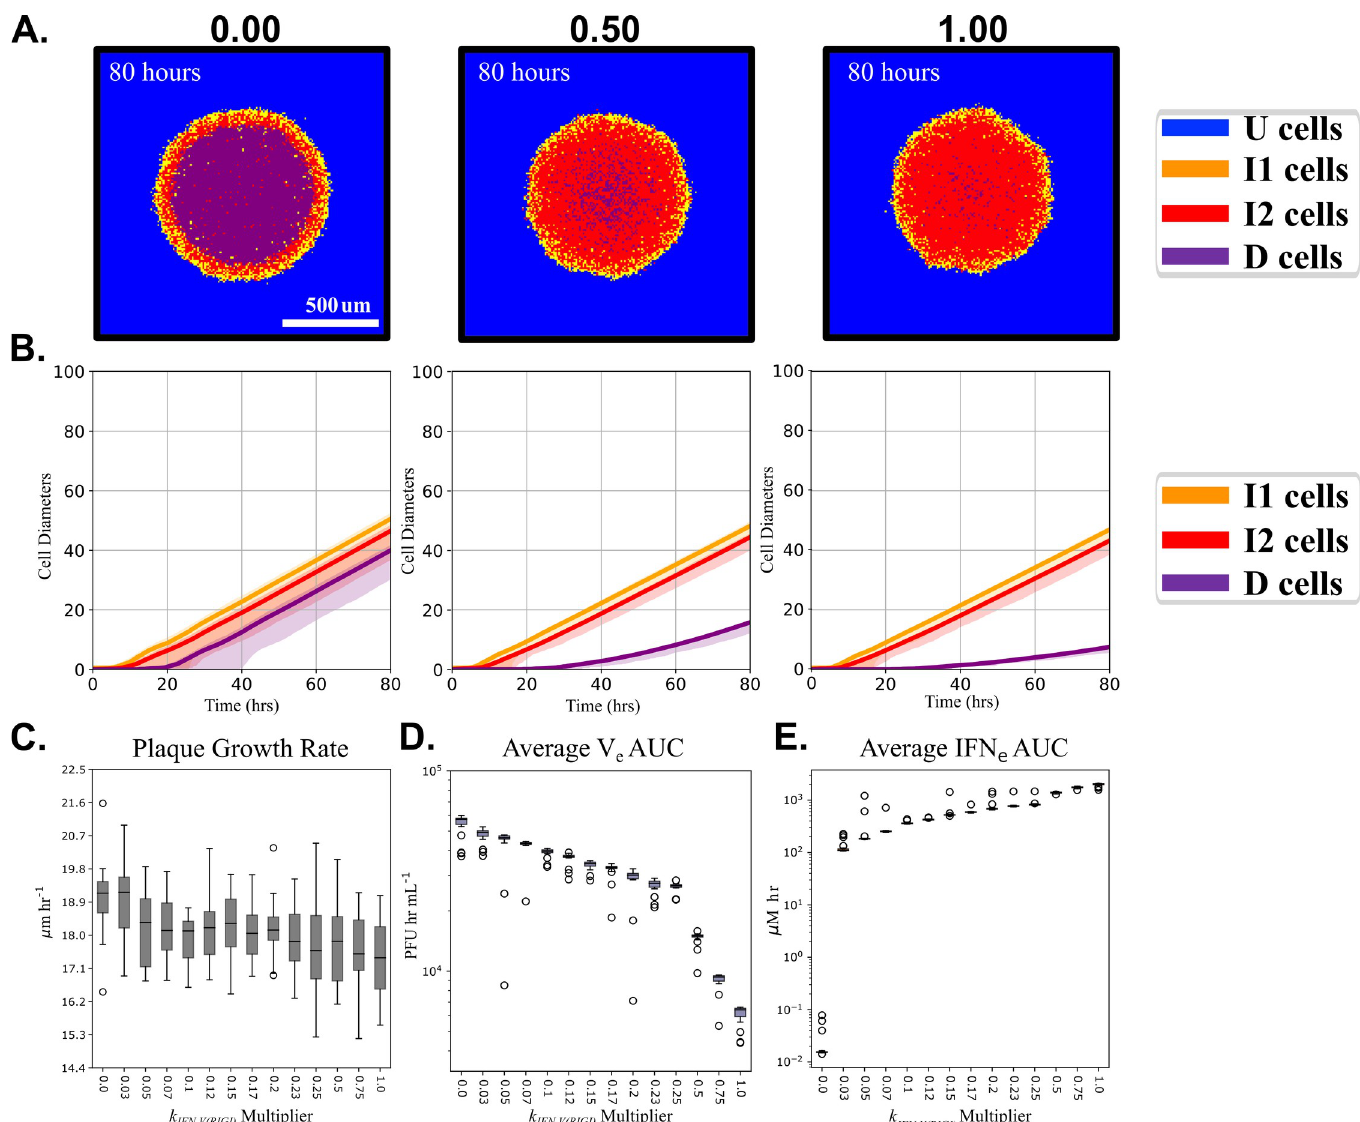
Fig 6. Increased RIG-I activity ( k IFN , V(RIGI) ) lowers plaque growth rates and viral titers, slows cell death, and increases interferon production. (A) Images of plaques at 80 hours post-infection for a representative simulation replica for three values of k (0.5E5 μ M hr -1 and 10E5 μ M hr -1 ) and (B) the median (solid line) and 5 th IFN , V(RIGI) and 95 th percentiles (shaded regions) of the plaque radius over time for 20 simulation replicas for k equal to 0x, 0.5x, or 1x its nominal value of 10E5 μ M hr -1 . (C) IFN , V(RIGI) The plaque growth rate at 80 hours, (D) the area under the curve (AUC) of the average V e , and (E) the AUC of the average IFN e for different values of k IFN , V(RIGI) , over 20 simulation replicas. Full data with 5 additional outliers for the plaque growth rate and the average V e AUC are available in S2 and S3 Figs, respectively.